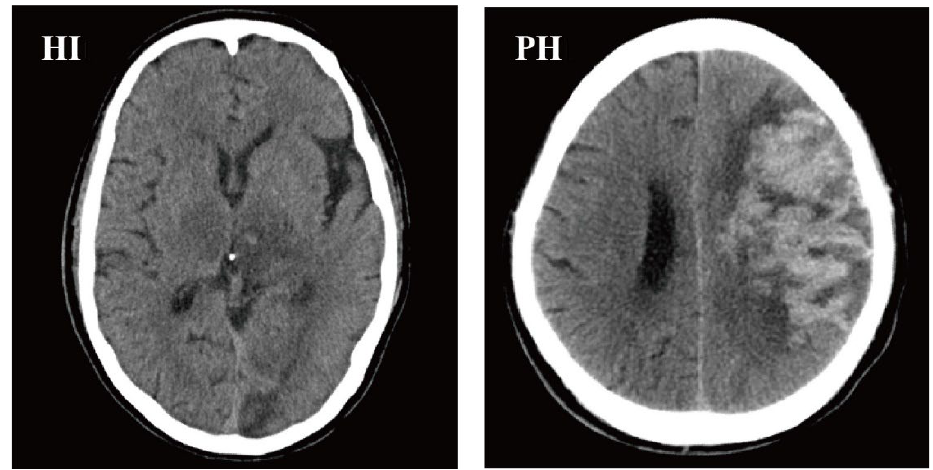
Figure 2. CT scan examples of HI and PH, according to the ECASS II classification. HI, hemorrhagic infarction; PH, parenchymal hemorrhage; ECASS II, European Cooperative Acute Stroke Study II.